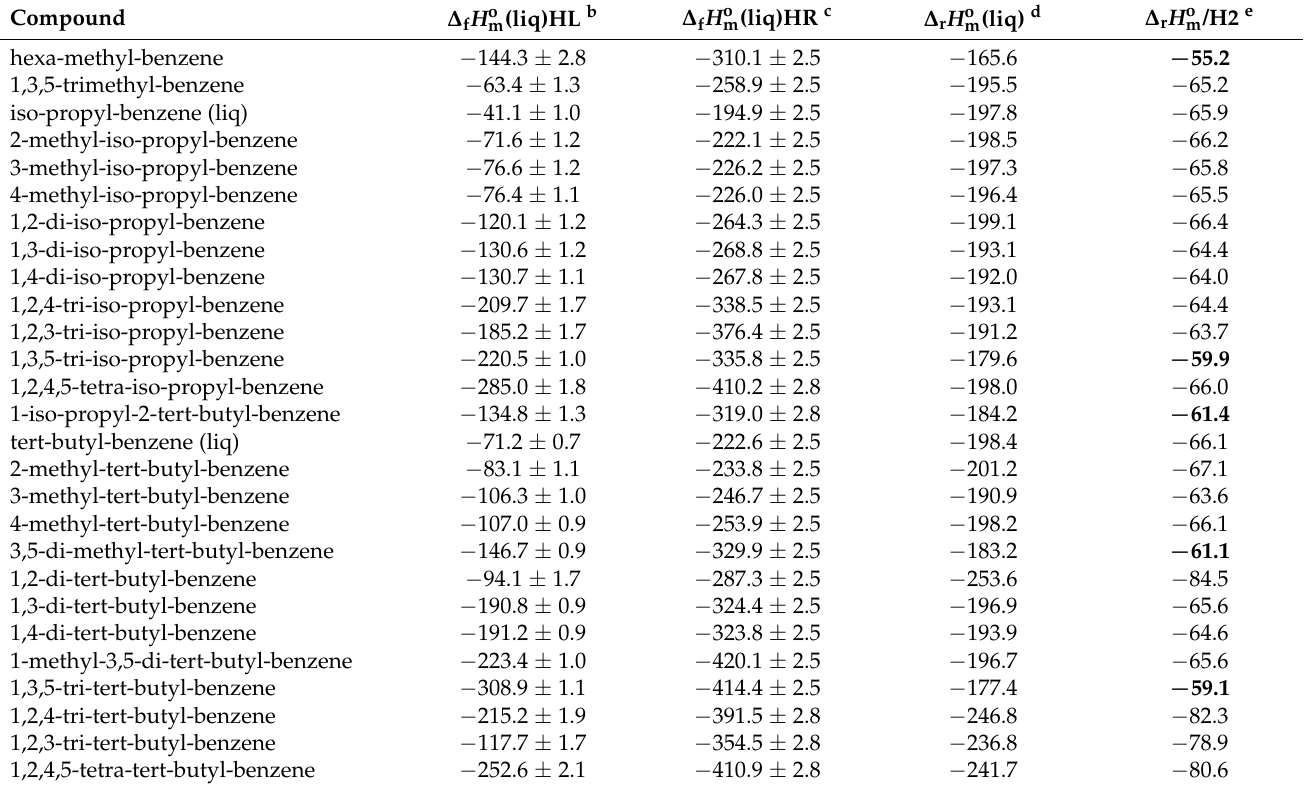
Table 12. Calculation of the liquid-phase enthalpies of formation, ∆ f H o m (liq), of the hydrogen- lean (HL) and hydrogen-reach (HR) counterparts of the LOHC systems based on alkylbenzenes